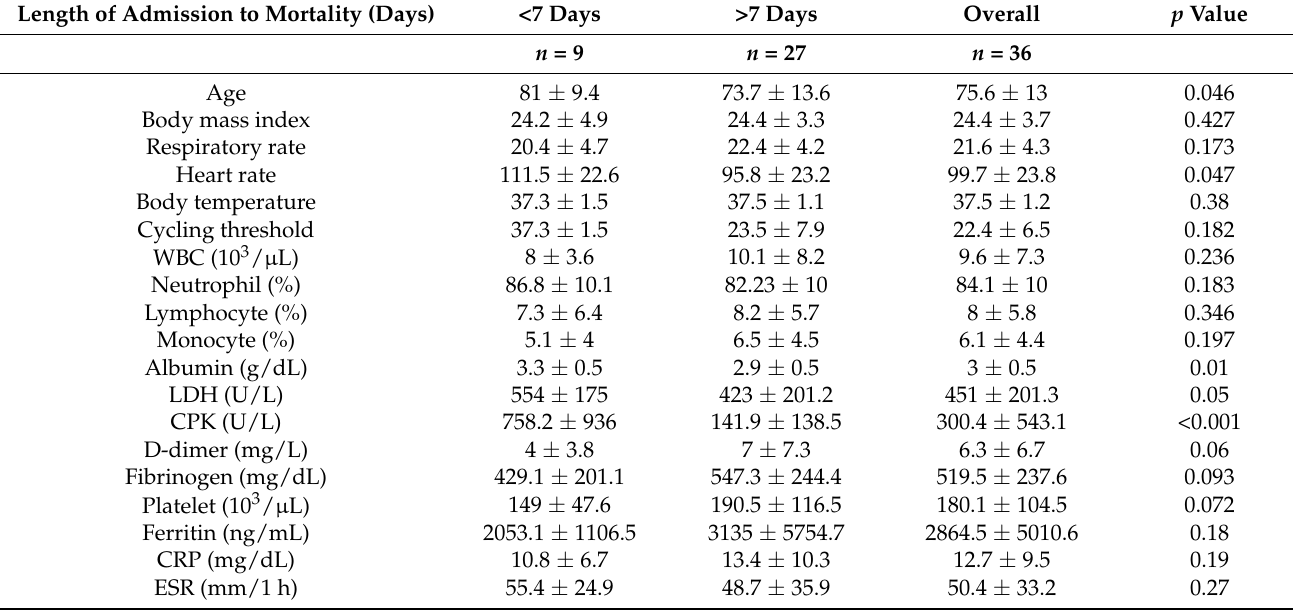
Table 2. Vital signs, cycle threshold (Ct) values, and biomarkers by patients’ groups.